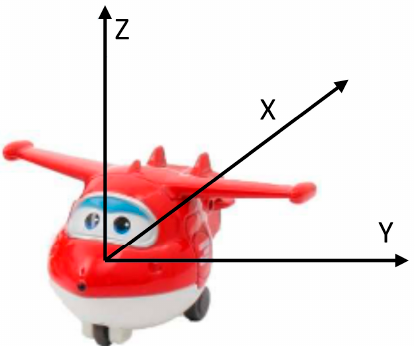
Figure 4. Super Wings smart toy: a detail of the orientation of the accelerometer axes.